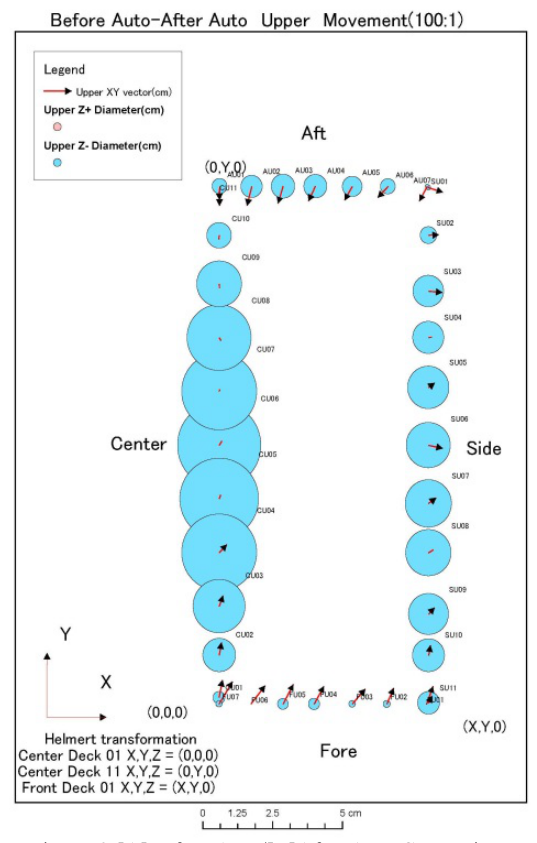
Figure 6. [A]Before Auto/[B]After Auto Comparison